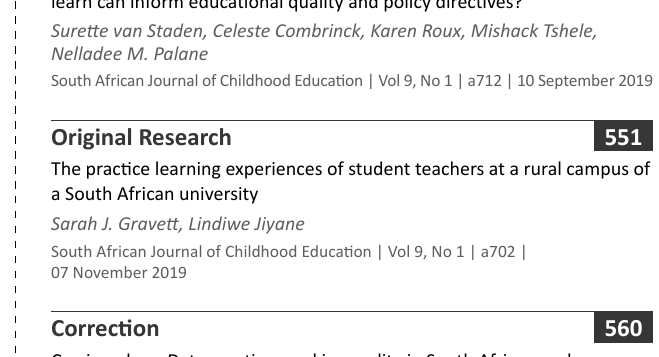
Moving beyond league table standings: How measures of opportunity to learn can inform educational quality and policy